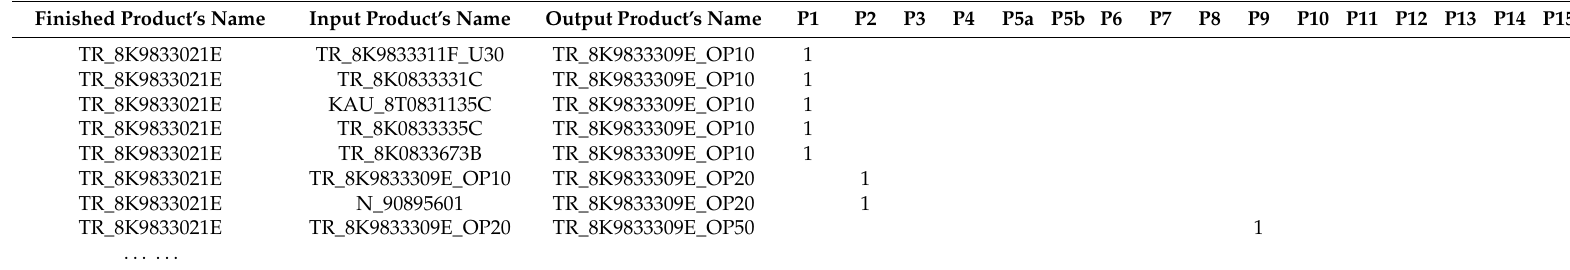
Table 10. Control data table.